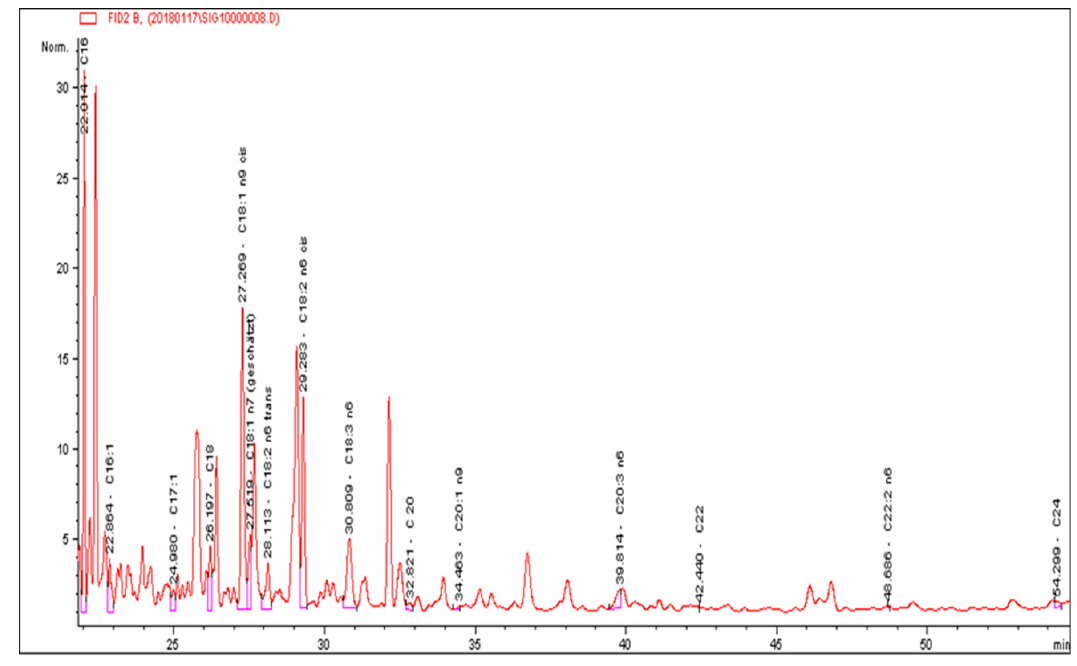
Figure 6. Chromatogram of total lipids obtained from C. sorokiniana microalgae biomass. Table 2. Fatty acid composition of lipids derived from С . sorokiniana biomass.